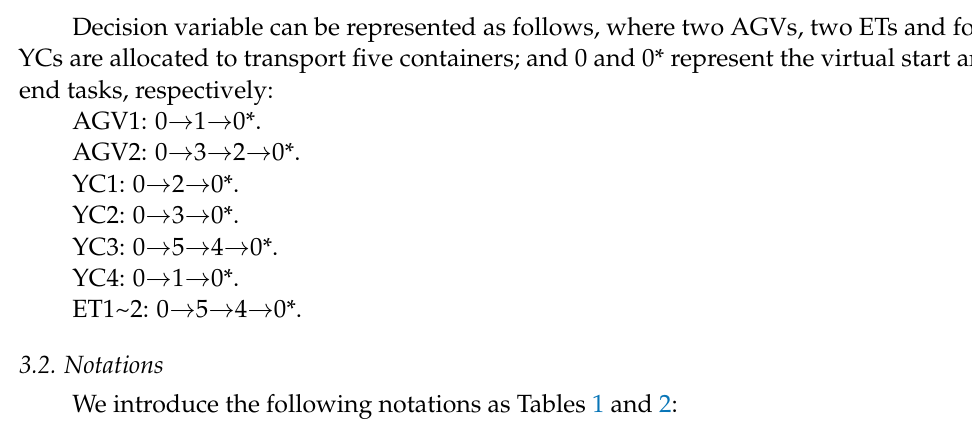
Figure 3. U-shape trafficked container yard layout.